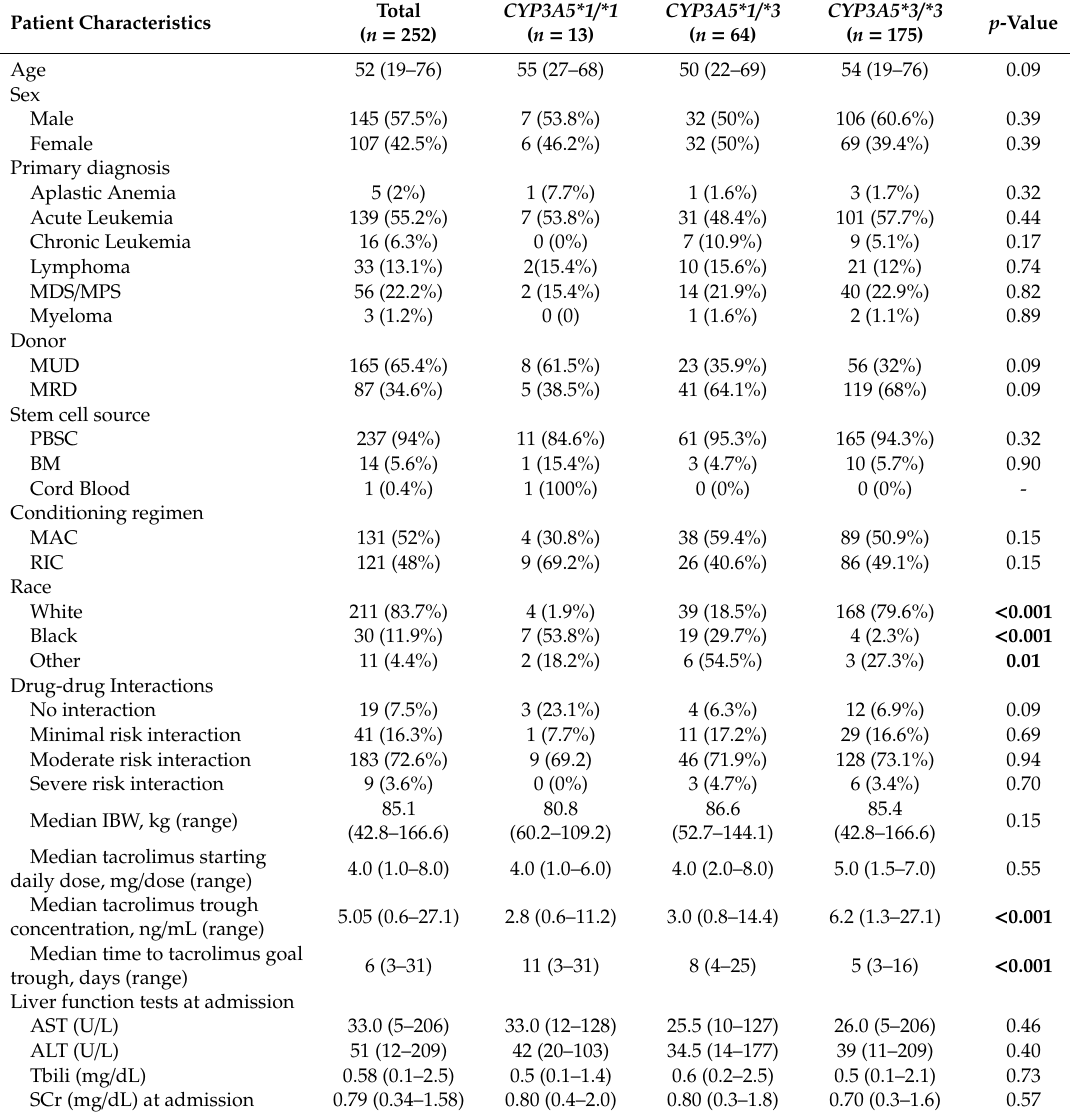
Table 1. Baseline clinical and demographic characteristics. Patients at our institution who received allogeneic hematopoietic stem cell transplant between January 11, 2011 and May 31, 2016 were consented, and enrolled in this tacrolimus pharmacogenetics study ( n = 252). Associations with p < 0.05 are considered significant and are bolded